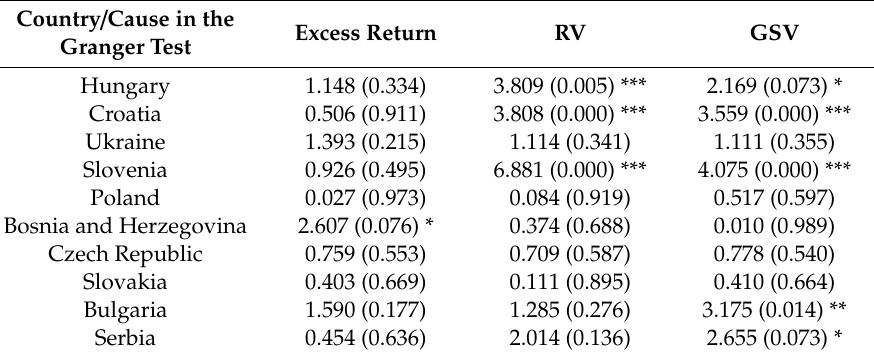
Table 3. Granger causality